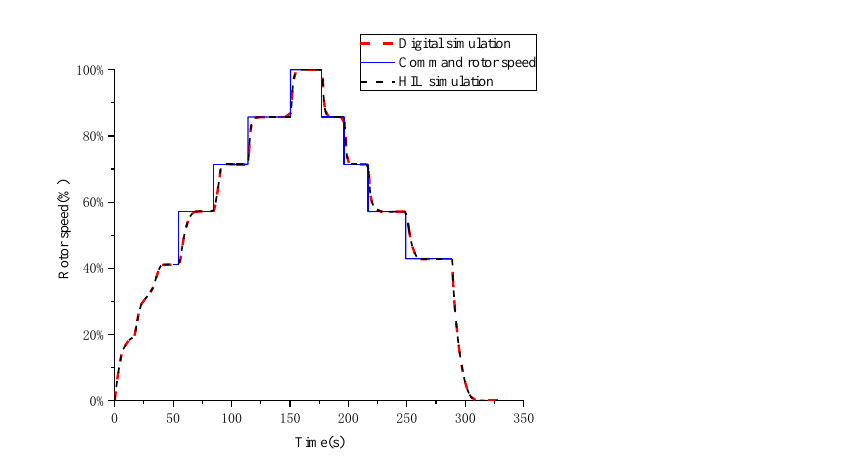
Figure 27. Rotor speed control comparison between HIL and digital simulation.